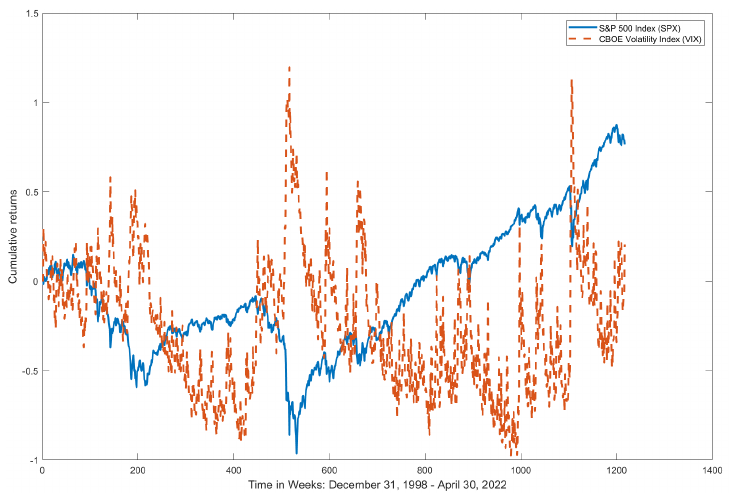
Figure 1. Observed SPX and